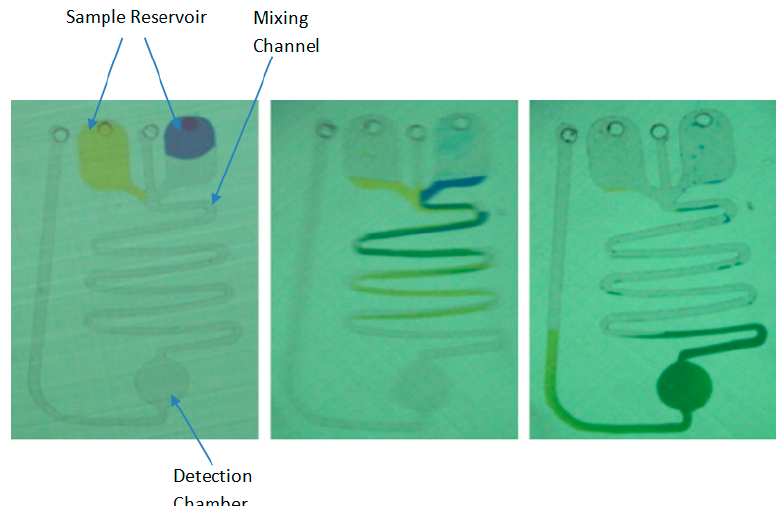
Figure 1. Microfluidic disc with two sample reservoirs and one mixing channel. After injecting samples into the reservoir in an uneven manner and applying centrifugal force, the sample with more volume starts flowing faster, and the uniform mixing is achieved in the long mixing channel. Taken with permission from [30].